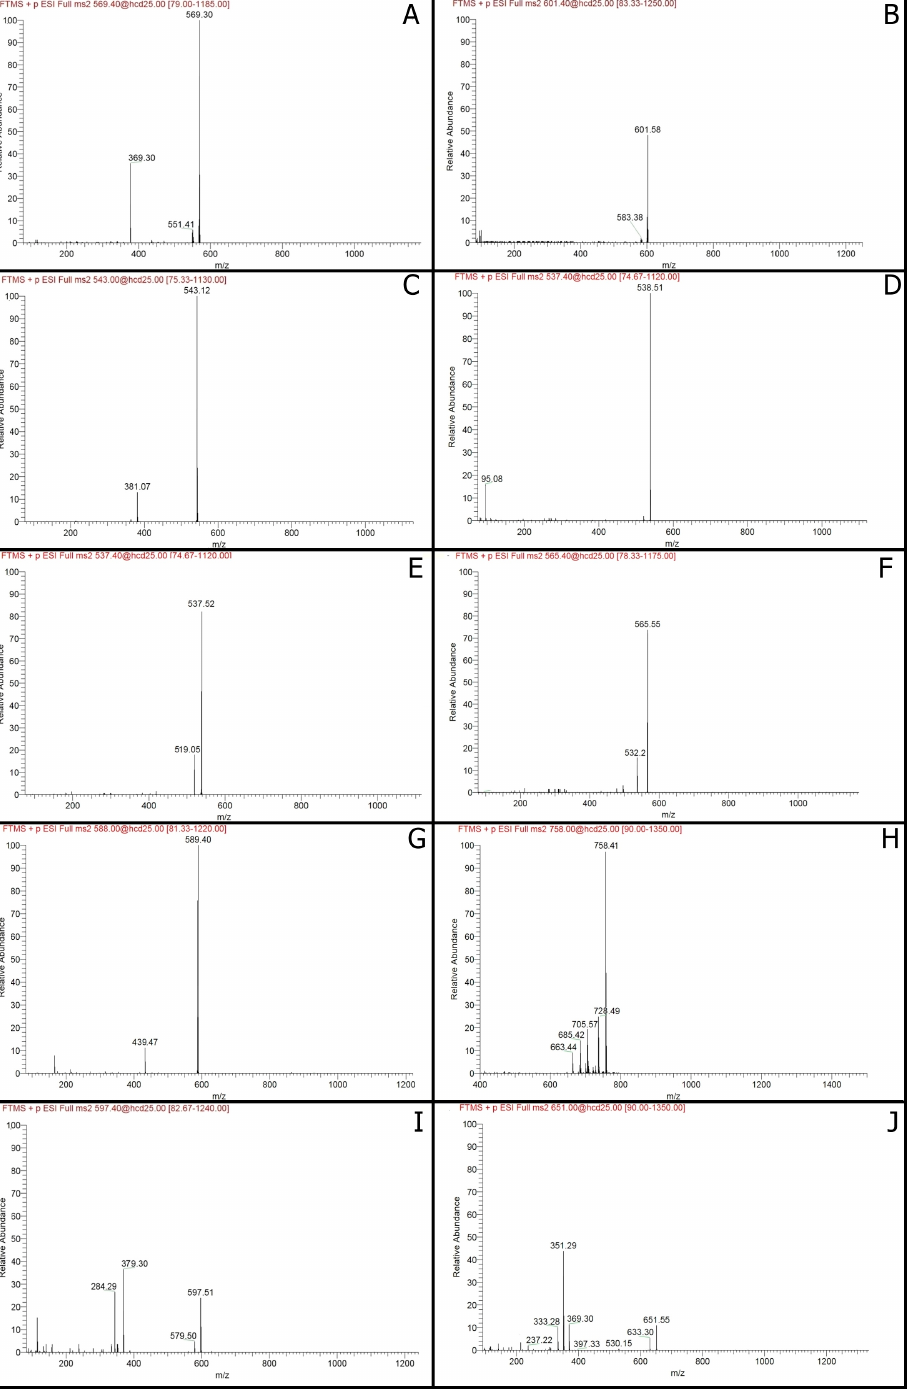
Figure 1. Mass spectra obtained using UHPLC-DAD-ESI-MS. ( A ) zeaxanthin; ( B ) neoxanthin; ( C ) phytofluene; ( D ) neurosporene; ( E ) α -carotene; ( F ) canthaxanthin; ( G ) synechoxanthin; ( H ) myxoxanthophyll; ( I ) astaxanthin; and ( J ) menaquinone-7.